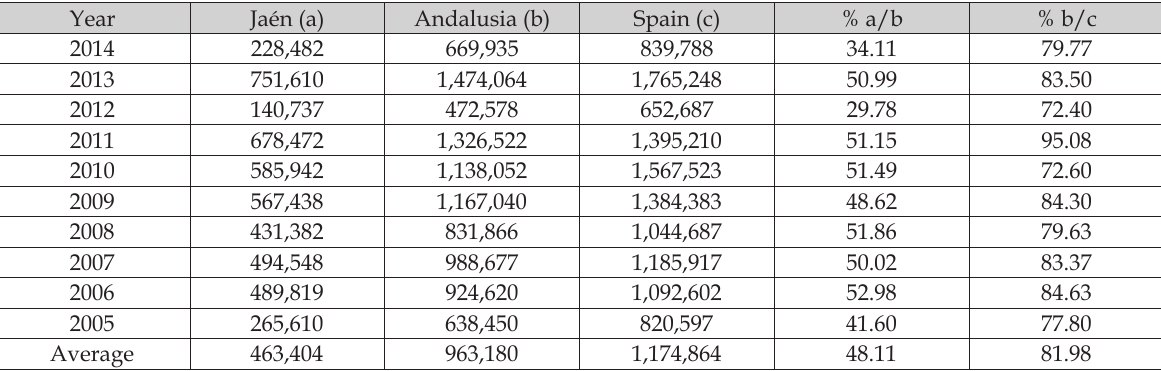
Table 4. Index of the concentration of the production of Spanish virgin olive oil (tonnes) in Andalusia and the importance of that obtained in Jaén compared with Andalusia during the period